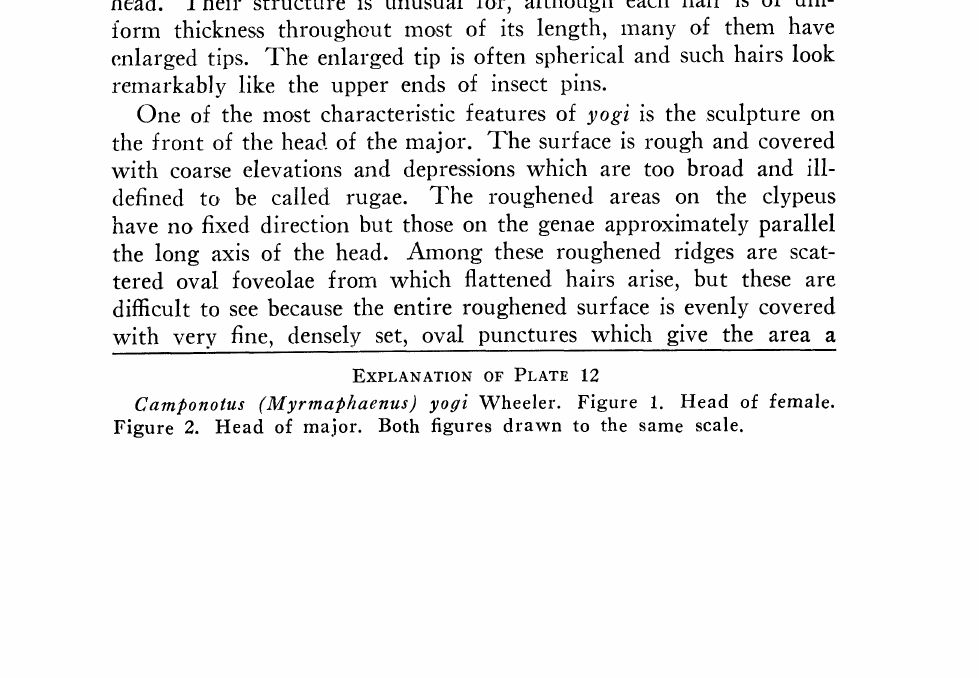
Figure 2. Head of major. Both figures drawn to the same